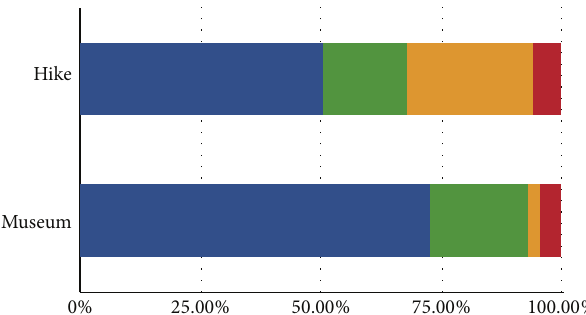
Figure3:Blueindicatesthepercentageofstudents’commentsabout their photos that were coded as documentation. Green indicates the percentage of students’ comments that were coded as observations. Yellow indicates the percentage of students’ comments coded as inferences. Red indicates codings for